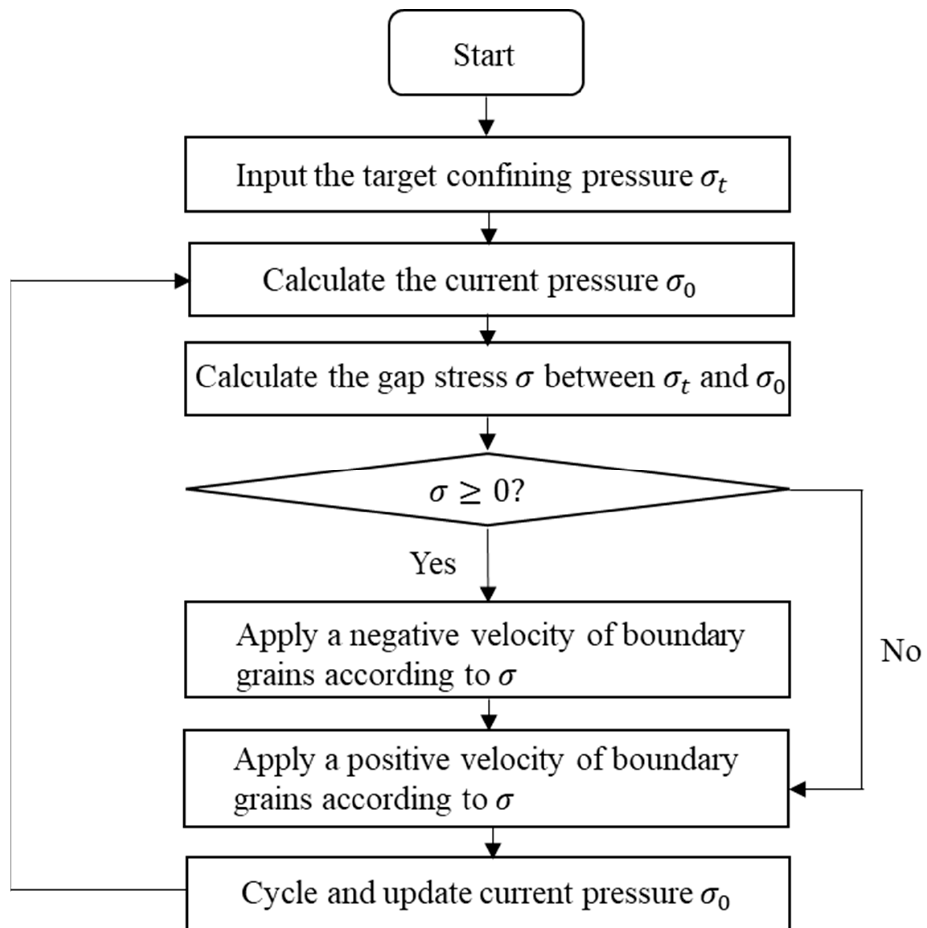
Figure 1. Confinement servo process in DEM.